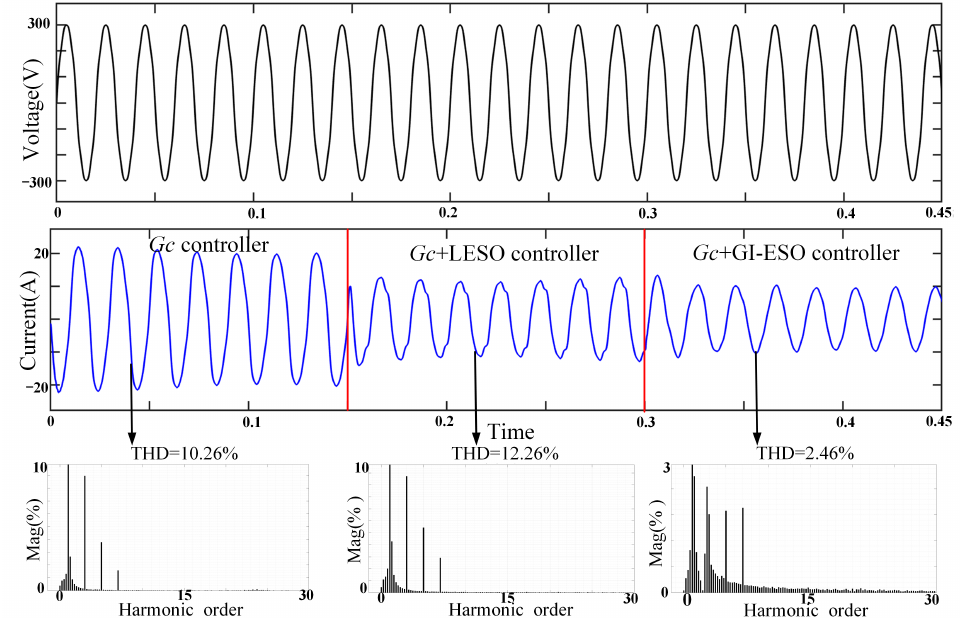
Figure 11. Grid-connected current when the grid voltage contains a large number of low order harmonics.